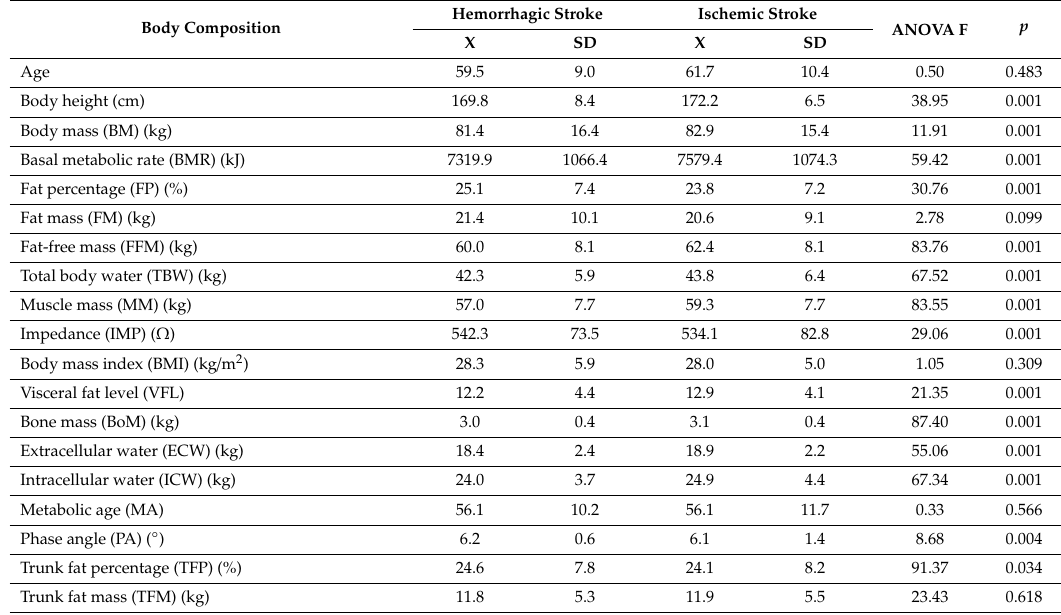
Table 1. Di ff erences in body composition between hemorrhagic and ischemic stroke. Body